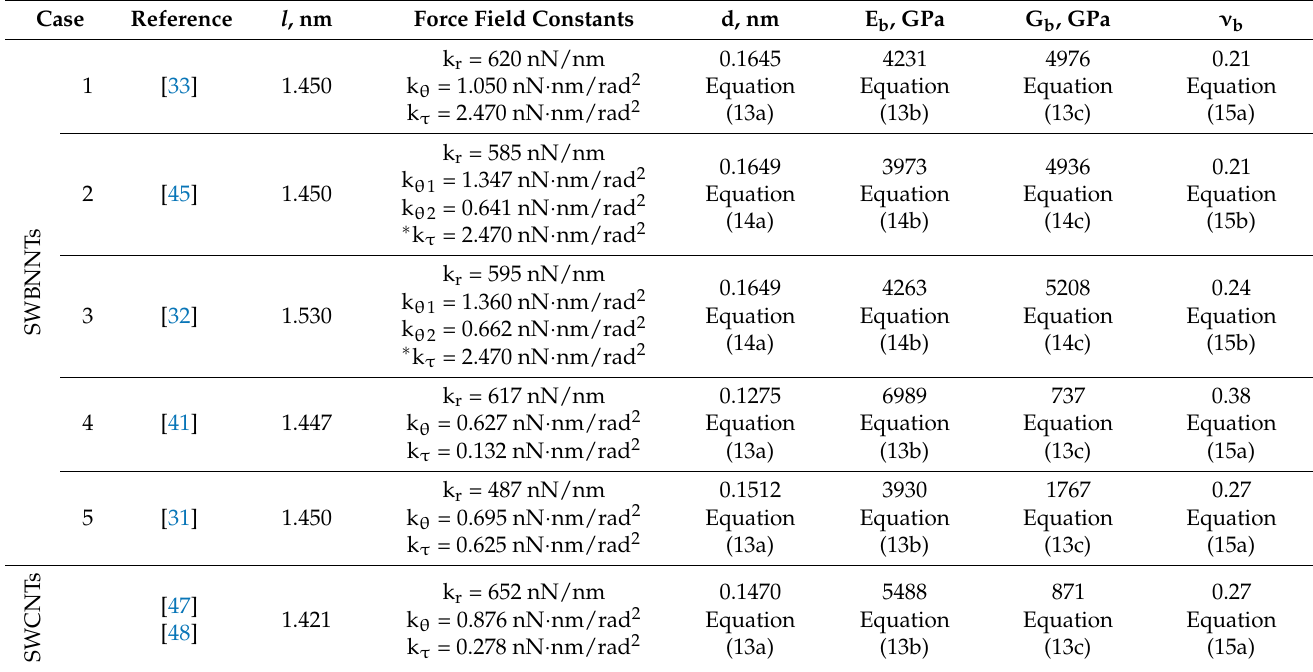
Table 3. FE simulations input parameters of SWBNNTs and SWCNTs: beam element geometrical and mechanical properties.